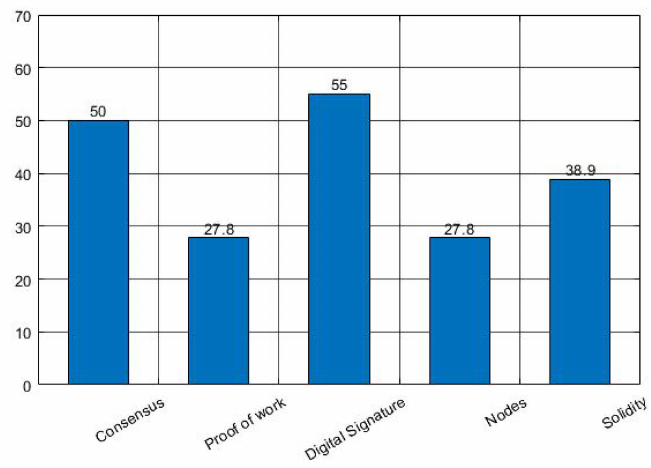
Figure 15. Various platforms in which blockchain is being